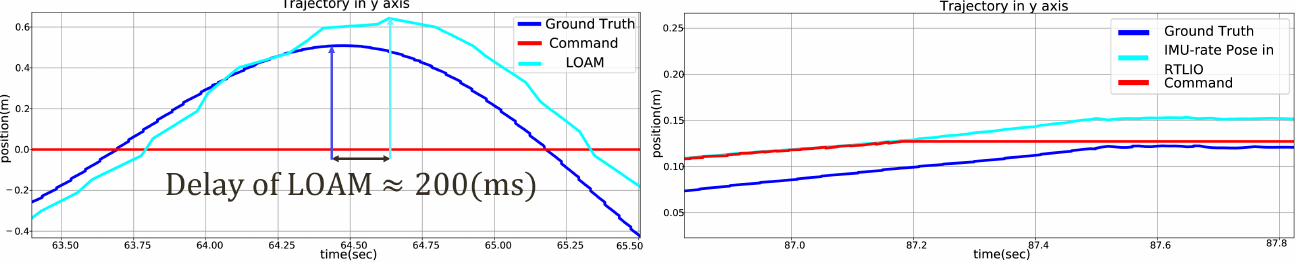
Figure 11. Time delays for ( left ) LOAM, ( right ) IMU-rate pose in RTLIO.